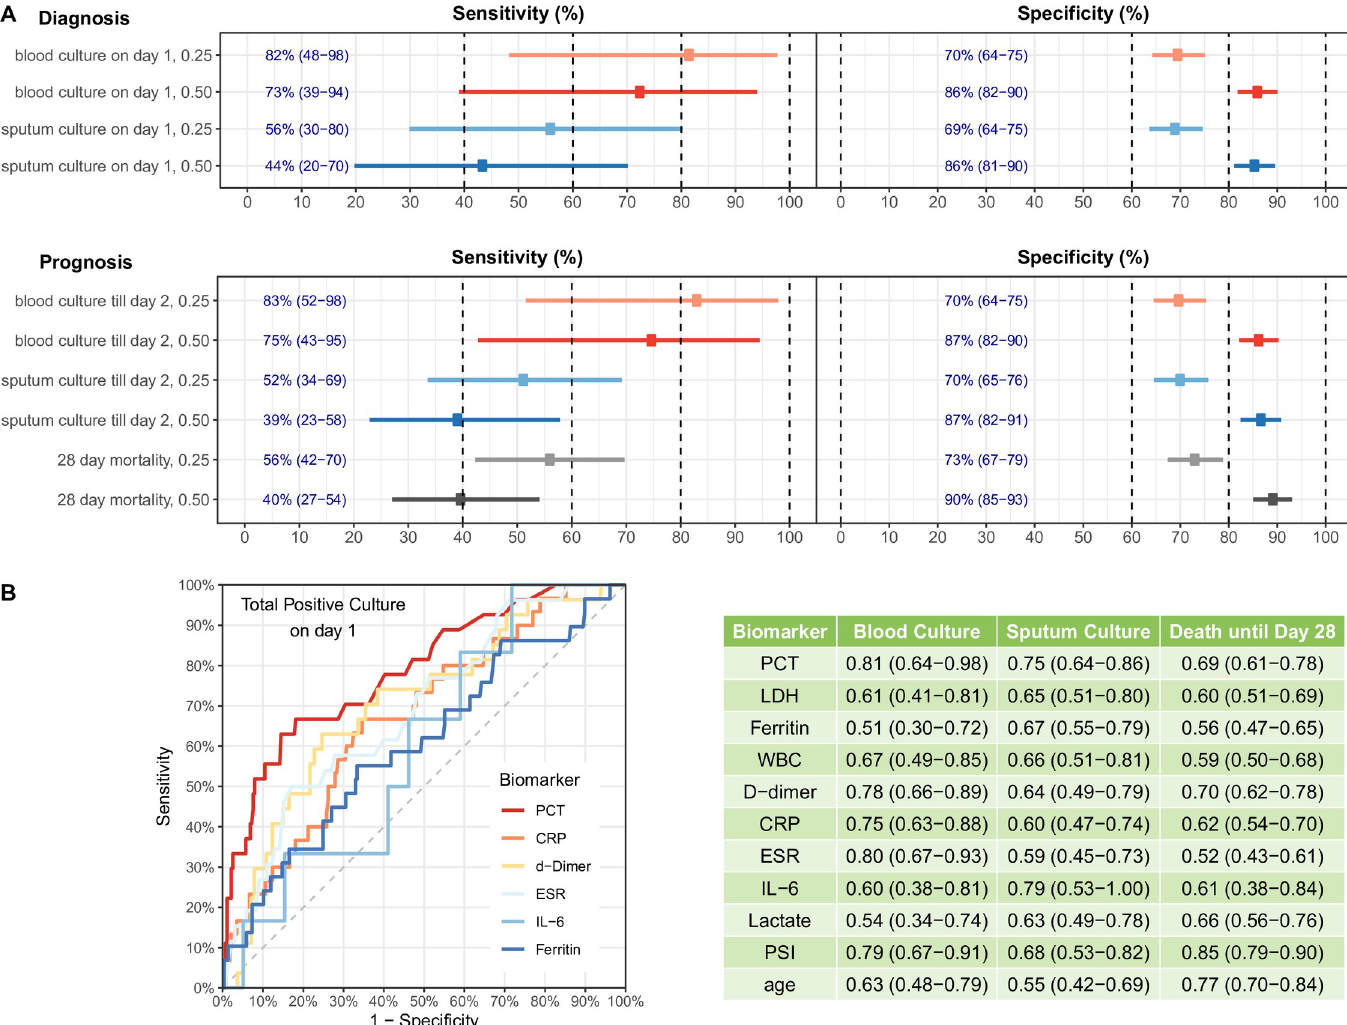
Fig 3. Diagnostic and prognostic performance of PCT levels in determining bacteremia, sputum culture and death by day 28 (Panel A). ROC curves for inflammatory biomarkers (Panel B, left). Biomarker AUCs for determination of death, blood, and sputum cultures (Panel B, right).